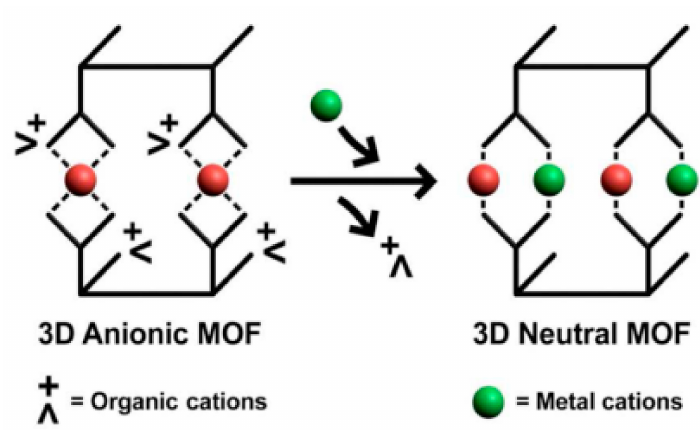
Figure 21. Scheme showing the incorporation of transition metal (TM 2 + ) cations into the anionic networks to a ff ord neutral and heterobimetallic systems via ligand directing single-crystal-to-single-crystal structural rearrangement